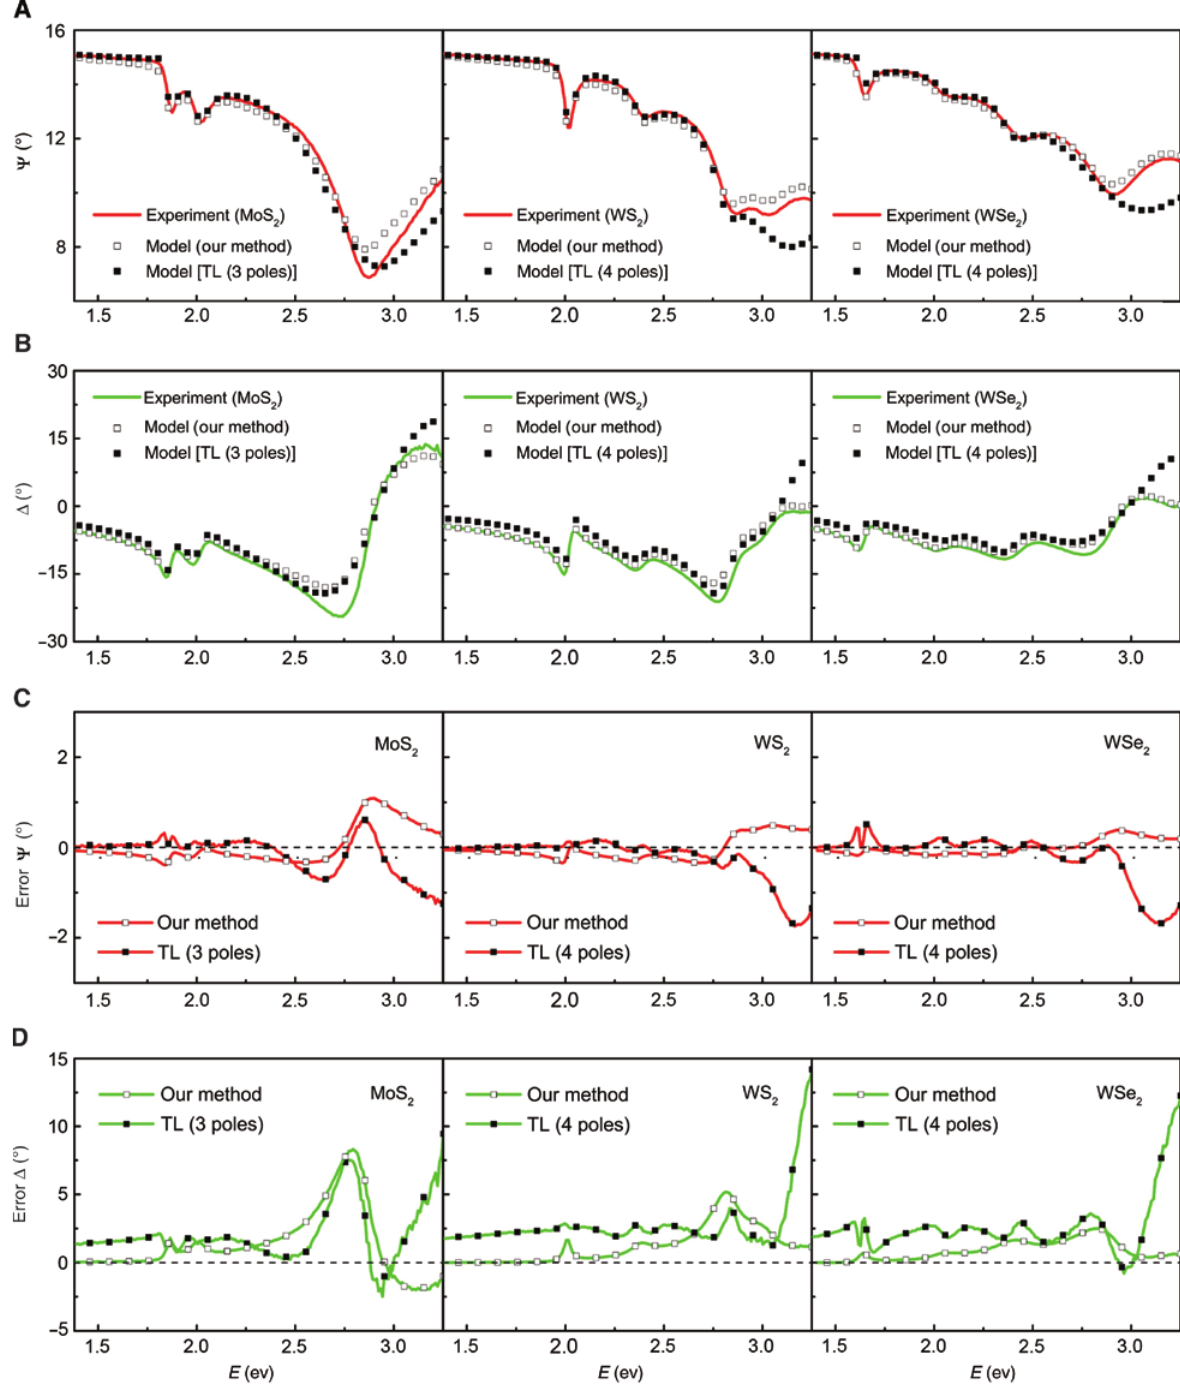
Figure 4: The errors compared to the conventional method. (A) Reflection amplitude ratio ( ψ ) and (B) phase difference Δ . Solid lines: experimental results; white squares: results of our method; black squares: results of TL fitting with N poles. (C) Errors in the amplitude ratio 〈 δ ψ 〉 and (D) errors in the phase difference 〈 δ Δ 〉 of monolayers of MoS (left column), WS (middle column), and WSe (right column). Solid lines with white squares show the errors in the results of our 2 2 2 method and solid lines with black squares are the errors in the results of the TL fitting method with N